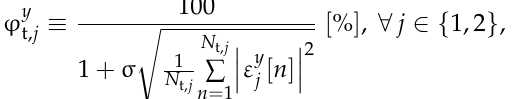
formula, the first values of std are the ones that lie at the right side end. Normally,